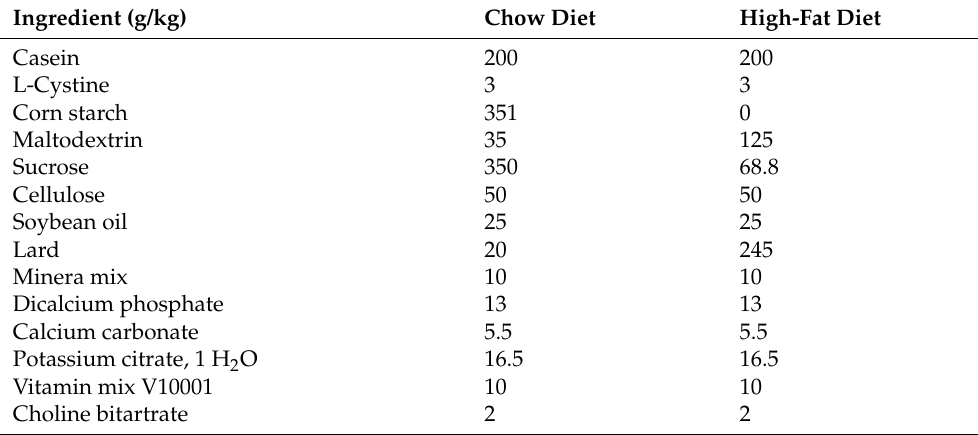
Table 1. Composition of normal chow diet and high-fat